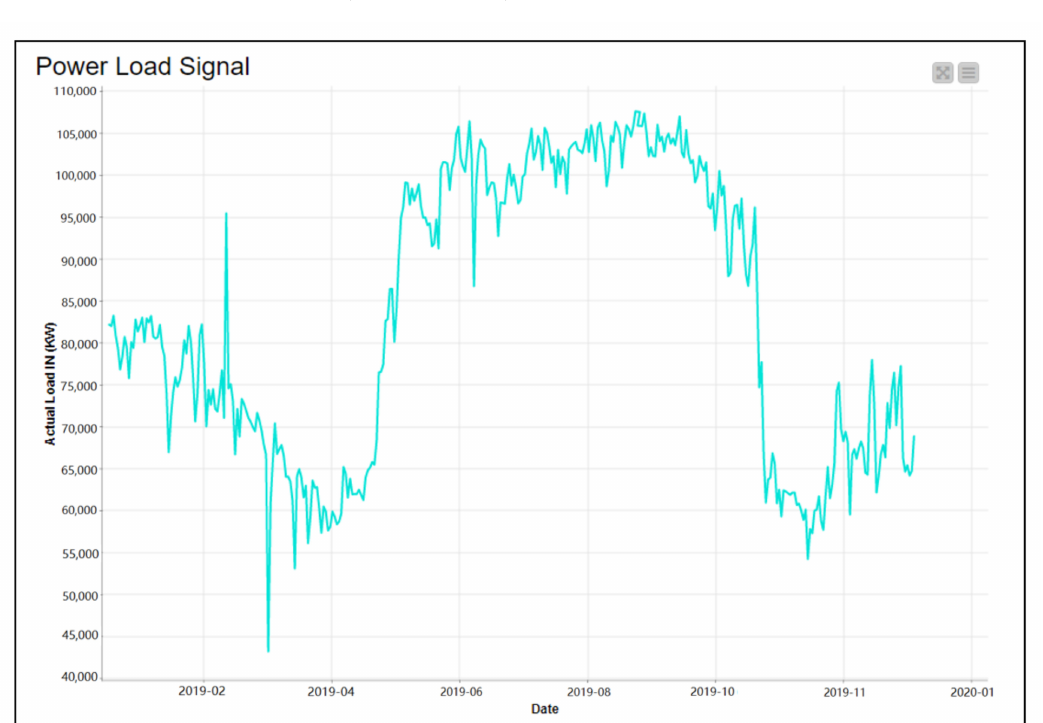
Figure 14. Daily Baghdad Governorate Load Distribution (KW) for 2019.